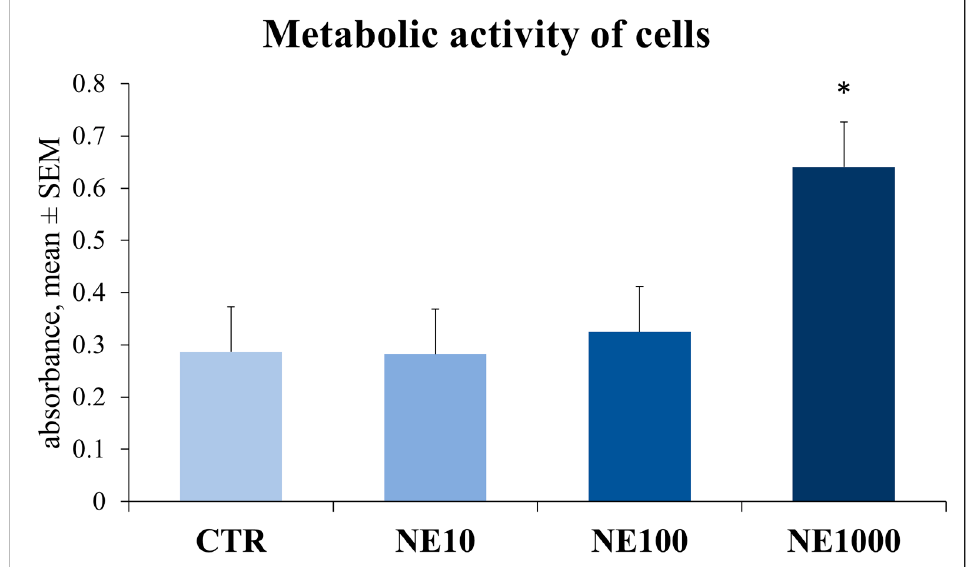
Figure 5. Metabolic activity of cells after 1-h norepinephrine treatment. CTR = non-treated control cells, NE10 = 10 µM norepinephrine treated cells, NE100 = 100 µM norepinephrine treated cells, NE1000 = 1000 µM norepinephrine treated cells. n = 5/group, results are expressed as mean ± SEM, * p < 0.05 . There were no significant changes in extracellular LDH activity after NE treatments compared to the non-treated control cells ( p = 0.603, p = 0.807, p = 0.860 for 10, 100, and 100 µM NE, respectively) (Figure 6).